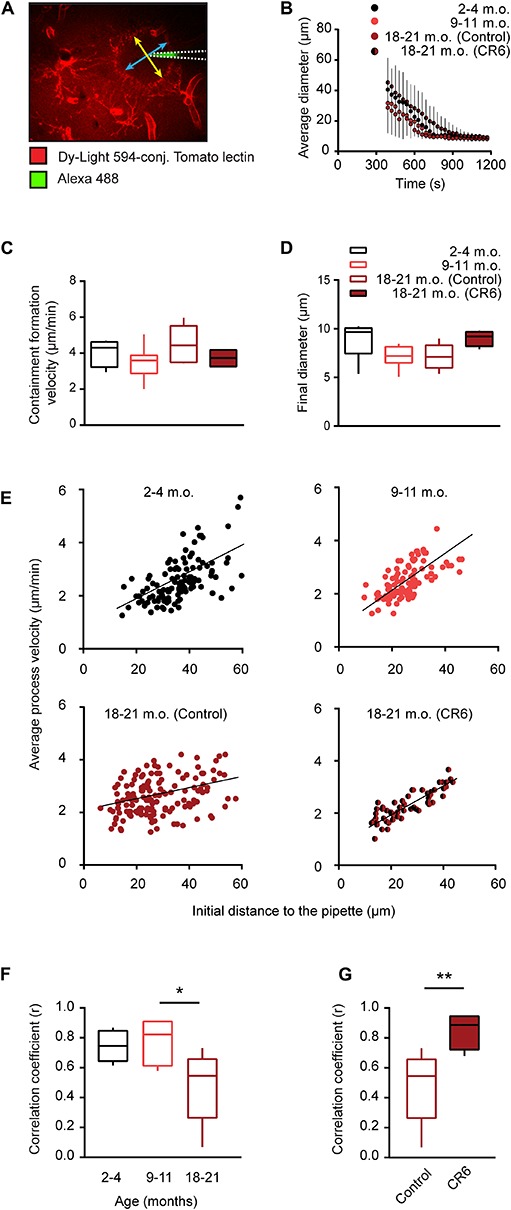
Effect of caloric restriction on ATP-induced process chemotaxis of microglia. (A) MIP image of a Z stack (80–100 μm below the cortical surface, 2 μm step size) exemplifying the containment formation by microglial processes labeled with DyLight 594-conjugated Tomato lectin in a 3-month-old mouse. The stack was taken 10 min after pressure application (50 ms, 30 kPa) of 5 mM ATP. Yellow and blue arrows indicate the major and minor diameters of the containment, respectively. White dashed lines emphasize the location of the ATP-containing pipette. (B) Graph illustrating changes in the average diameter of the containment over time and the effect of CR. The moment of the ATP application was taken as time point 0. (C,D) Box-and-whisker plots illustrating the median (per mouse) containment formation velocity (C) and the final diameter of the containment (D) in 2–4- (n = 7 mice), 9–11- (n = 8 mice), 18–21- (n = 8 mice) month-old control mice, and in 18–21- (n = 4 mice) month-old CR6 mice. (E) Scatter plots illustrating the relationship between the initial distance of a microglial process to the tip of the ATP-containing pipette (X-axis) and the mean velocity of the process (Y-axis) in 2–4- (n = 6 mice, 118 processes), 9–11- (n = 6 mice, 119 processes), 18–21- (n = 8 mice, 146 processes) month-old control mice as well as in 18–21- (n = 4 mice, 58 processes) month-old CR6 mice. (F,G) Box-and-whisker plot illustrating median (per mouse) Spearman’s correlation coefficients between the initial distance of microglial processes to the tip of the ATP-containing pipette and the mean process velocity in the three age groups (F) as well as the 18–21 months old control and age-matched CR6 groups (G). Statistical differences between age groups were determined using Kruskal-Wallis test followed by Dunn’s post hoc test for multiple comparisons. For comparing control and CR6 mice Mann-Whitney test was used (*p < 0.05, **p < 0.01).